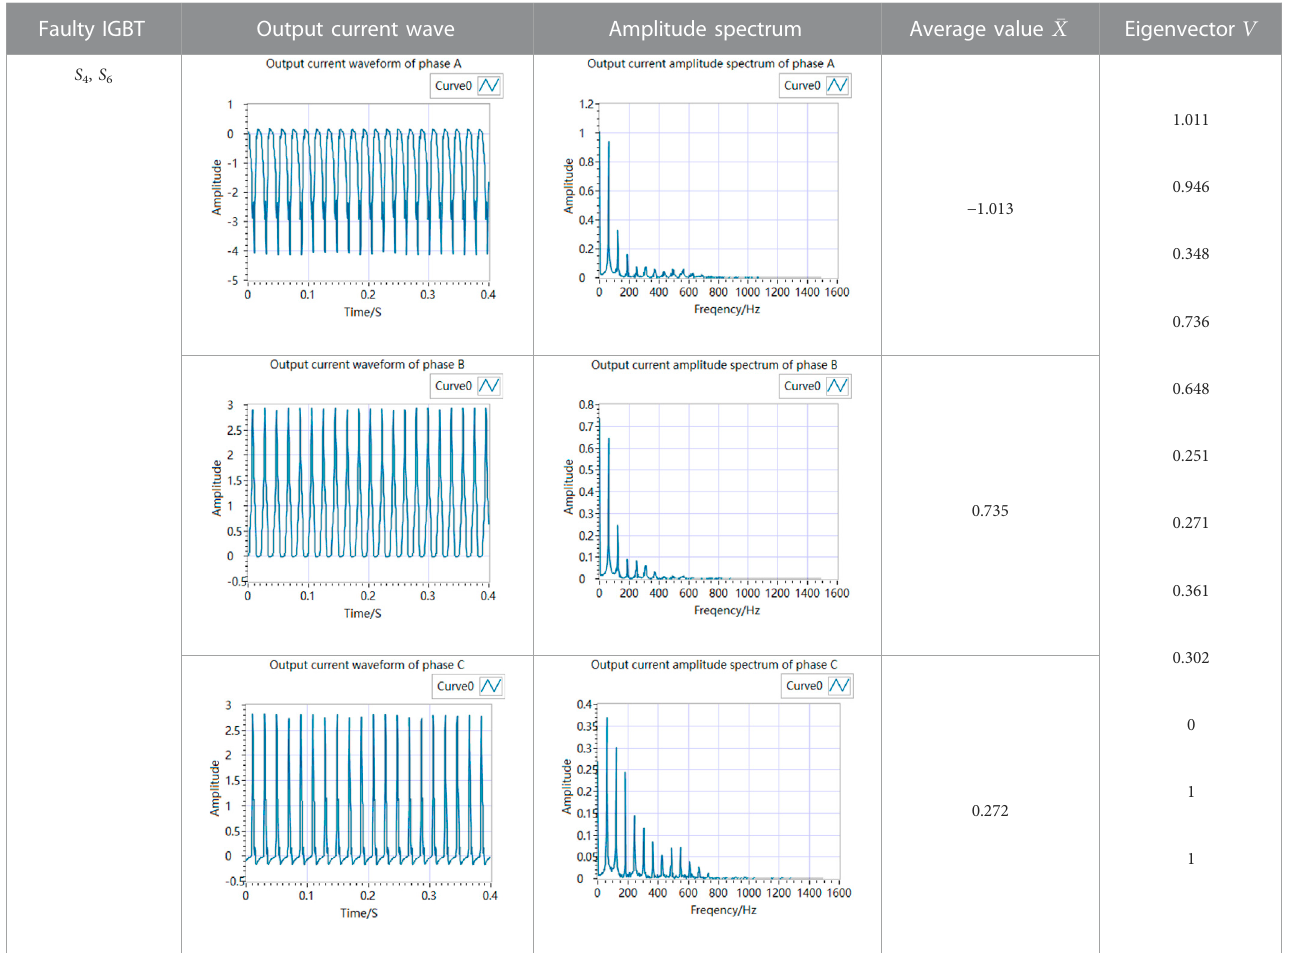
TABLE 2 Fault eigenvector and amplitude spectra of phase A, B, and C with S 4 and S 6 failure